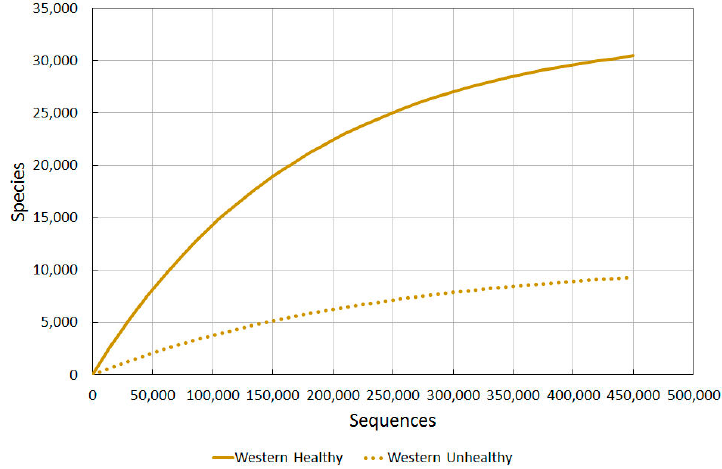
Figure 2. A comparison of bacterial diversity in healthy and unhealthy western skin. Rarefaction analysis using Chao1 3% index. analysis using Chao1 3%